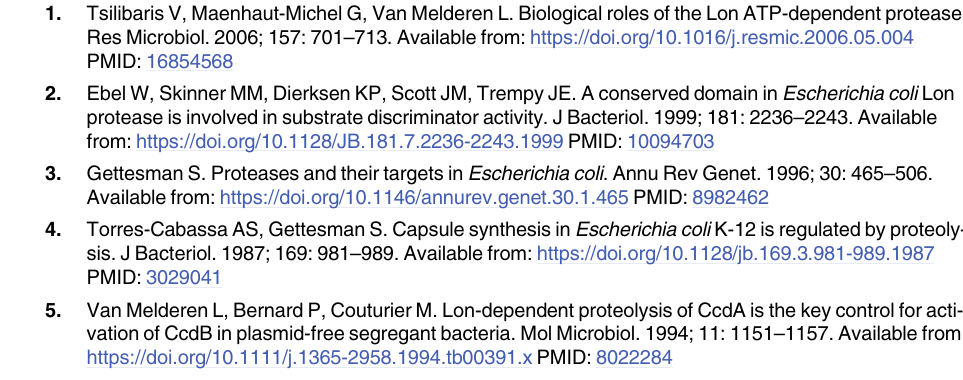
S1 Table. The strains and plasmids used in this study. S2 Table. The primers used in this